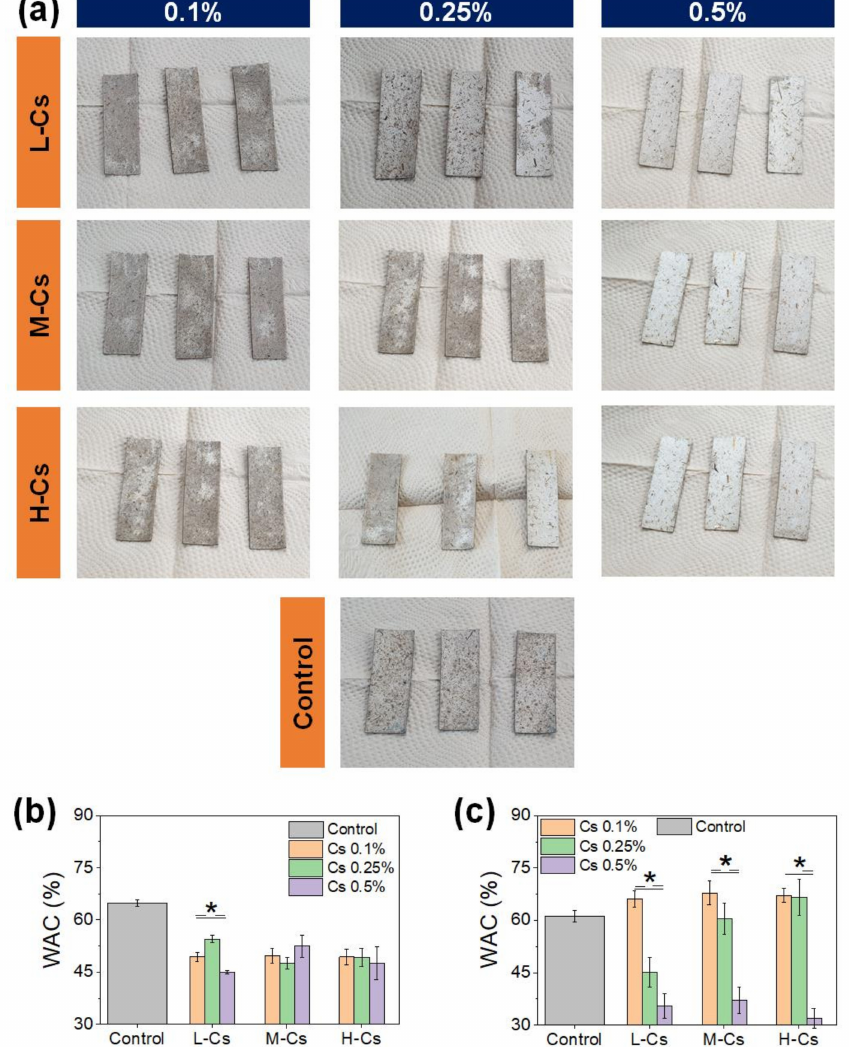
Figure 6. ( a ) Photographs of seaweed paper samples (High S%) coated with chitosan with varying concentrations and molecular weights, after immersing them in hot water. Water absorption capacity (WAC) values of ( b ) High S% and ( c ) Low S% seaweed papers coated with chitosan (* p < 0.05). Uncoated papers were used as